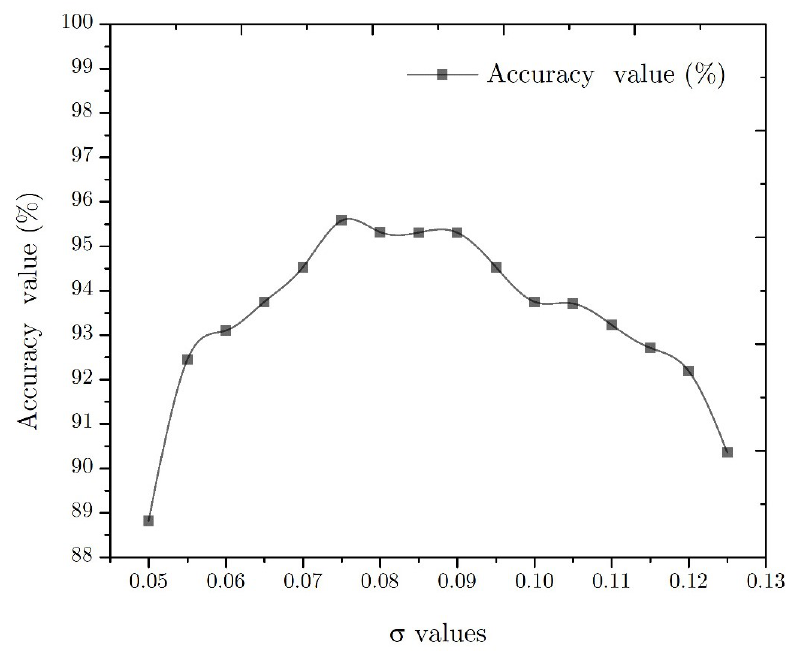
Figure 10. Variation of accuracy value for different values of σ